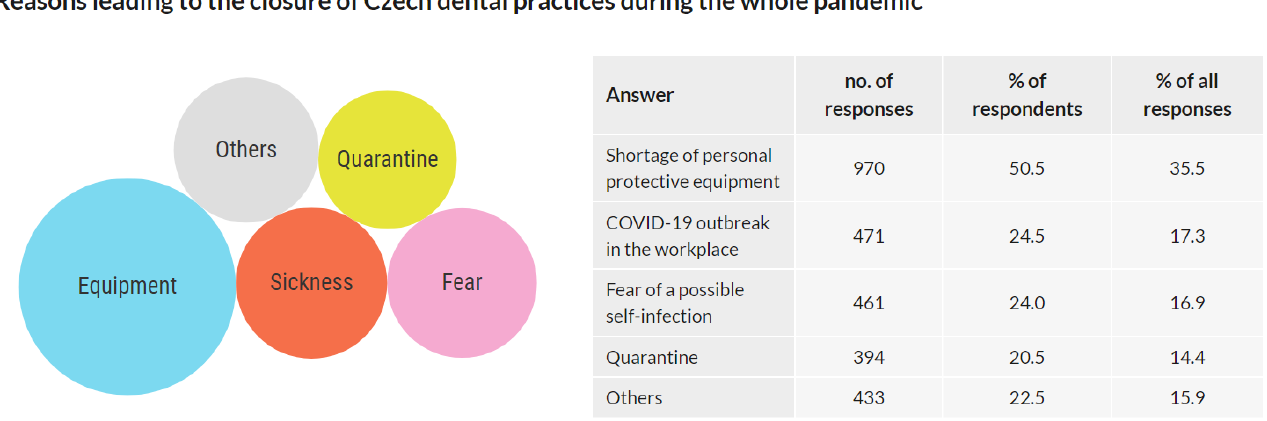
Figure 4. Reasons leading to the closure of Czech dental practices during the whole pandemic.